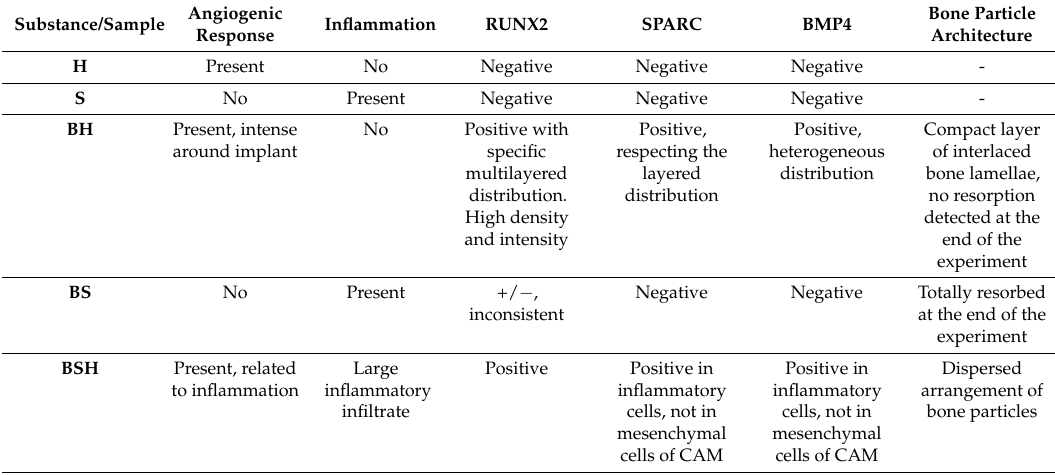
Table 1. A comparative overview of the effects of bone substitutes and different resuspension media on